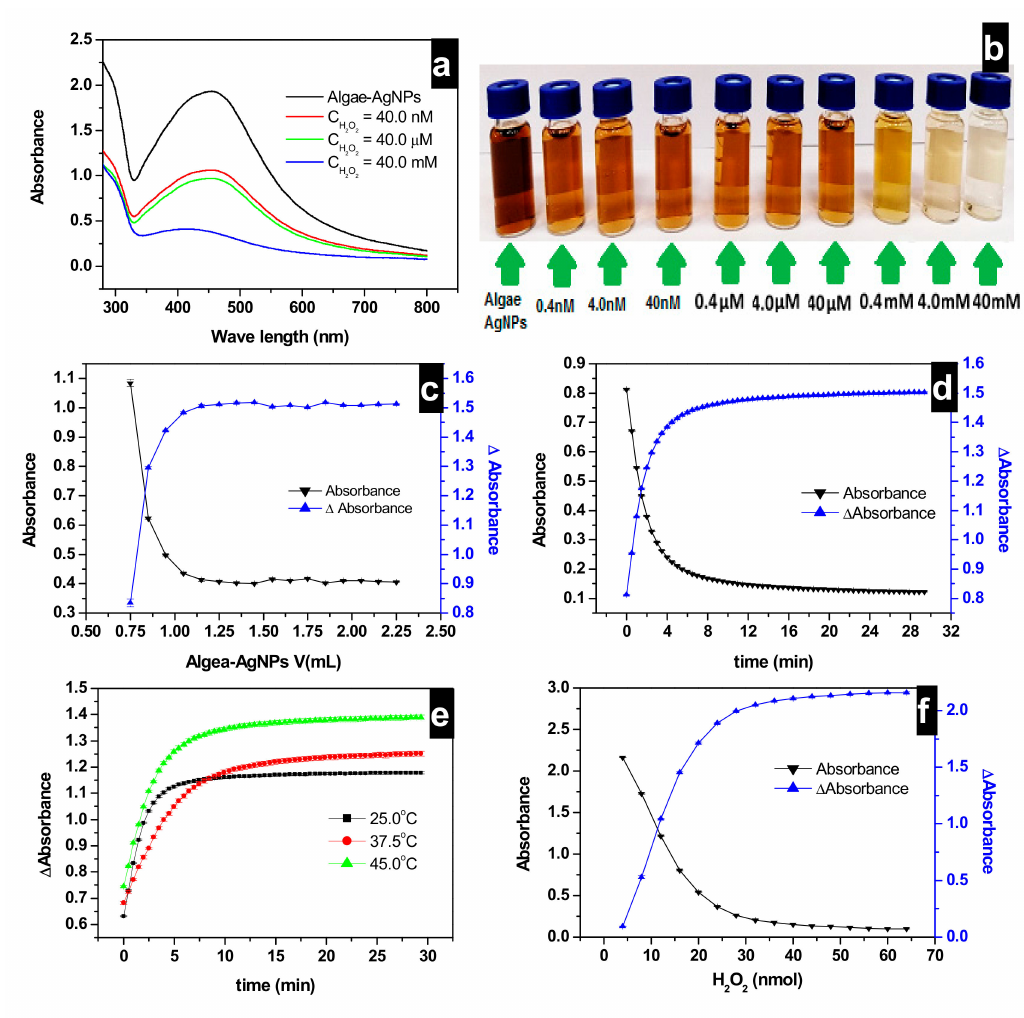
Figure 4. ( a ) LSPR absorbances of Algae-AgNPs at di ff erent concentrations of H 2 O 2 ; ( b ) color fading of Algae-AgNPs toward H 2 O 2 concentration increase from 0.4 nM to 40 mM; ( c ) e ff ect of Algea-AgNPs amount on H 2 O 2 detection at 25 ◦ C, C i = 40 mM; V i (AgNPs) = 0.75 mL; pH i (Algae-AgNPs) = 7.0; ( d ) e ff ect of time on H 2 O 2 detection by Algae-AgNPs as a function of equilibration time at 25 ◦ C; C i = 40 mM; V (Algae-AgNPs) = 0.75 mL; pHi (Algae-AgNPs) = 7.0; ( e ) e ff ect of temperature on H 2 O 2 detection by Algae-AgNPs at 25, 37.5, and 45 ◦ C; C i = 40 mM; V (Algae-AgNPs) = 0.75 mL; pHi (Algae-AgNPs) ≈ 7.0 and ( f ) evolution of LSPR absorbances of the Algae-AgNPs and LSPR ∆ Abs against the increase of the concentration of H 2 O 2 concentration in the 4.7 to 65 nM